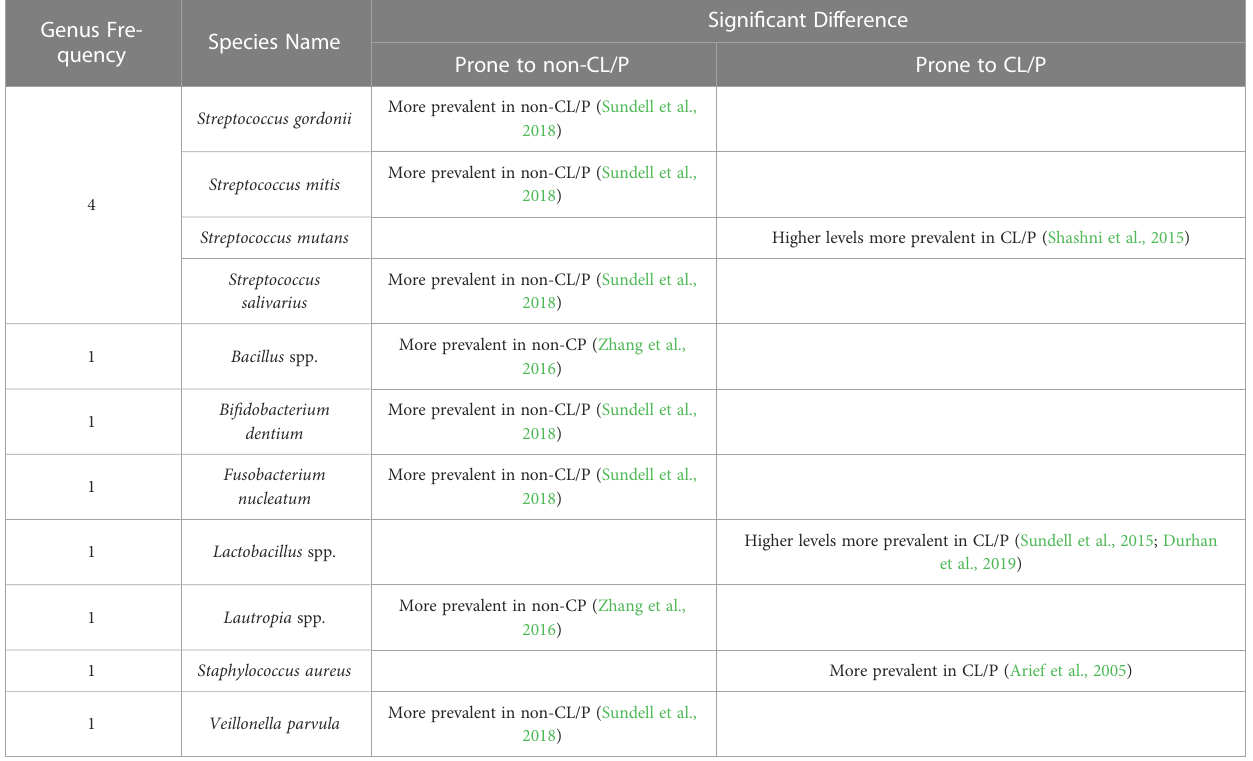
TABLE 3 Signi fi cant differences in bacterial species obtained from the saliva of CL/P and non-CL/P patients. Genus